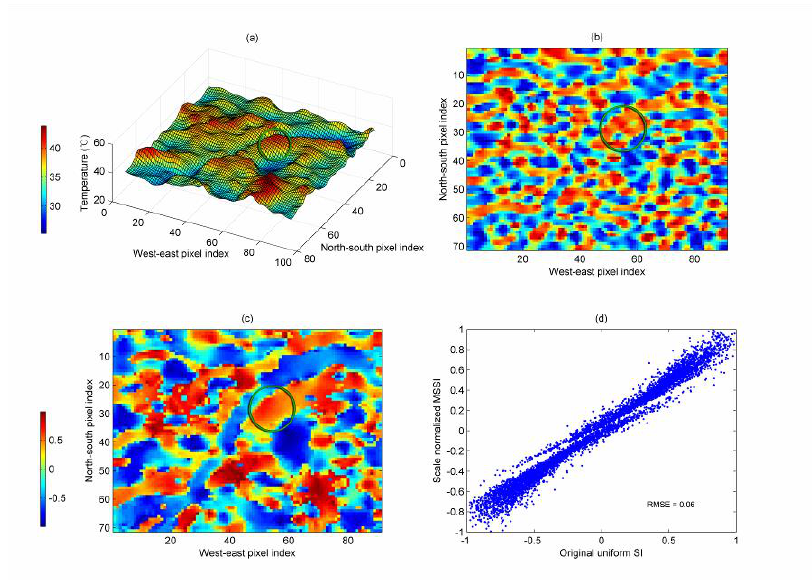
Figure 5: The application of the MSSI to the latent LST at 1330h of July 27th, 2012. (a) The latent LST. (b) The SI of the latent LST at uniform scale. (c) The MSSI of the latent LST surface. And (d) the scale normalized MSSI and the original SI comparison.